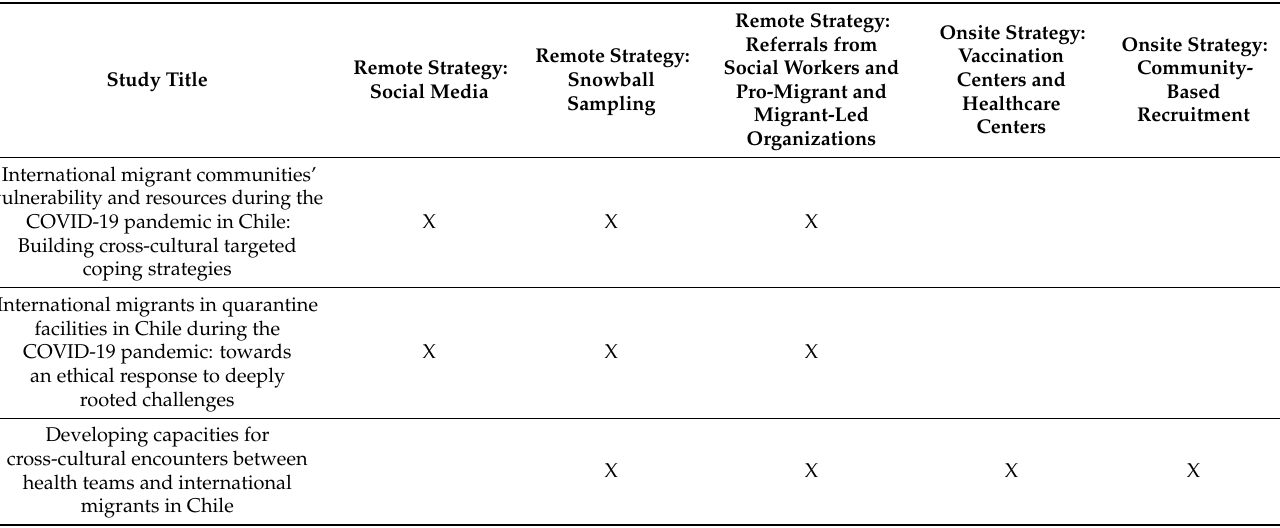
Table 2. Strategies implemented in each research